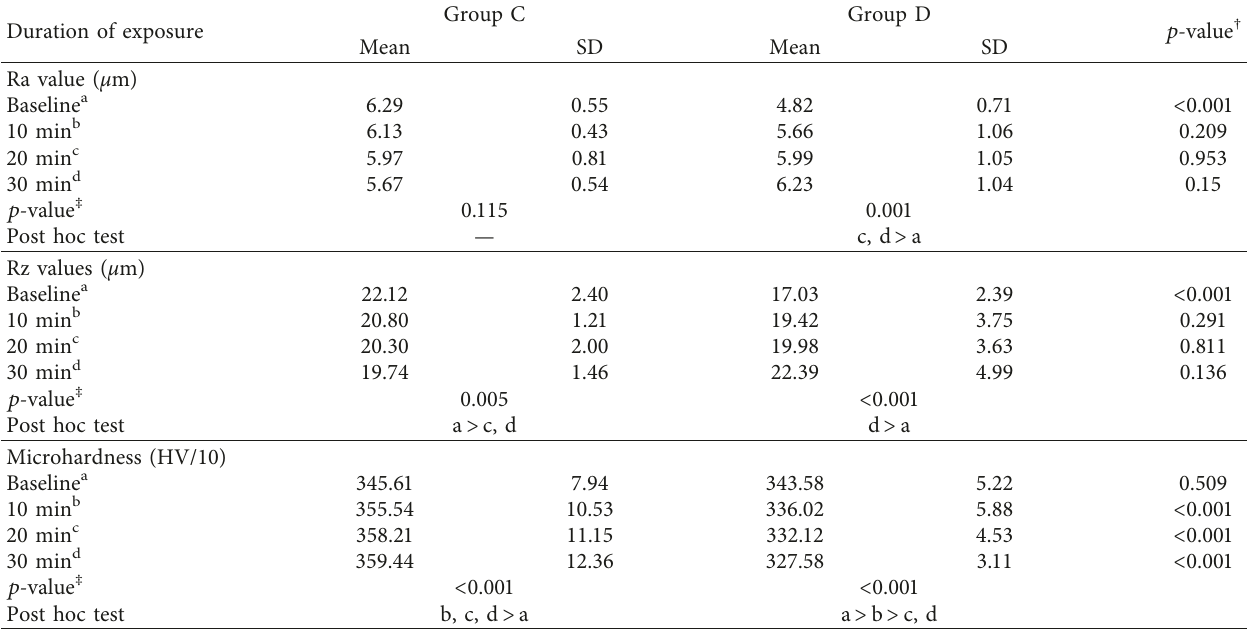
Table 2: Inter- and intragroup comparison of Ra (arithmetic average of surface roughness), Rz, and microhardness in groups C and D. Group C Group Duration of exposure